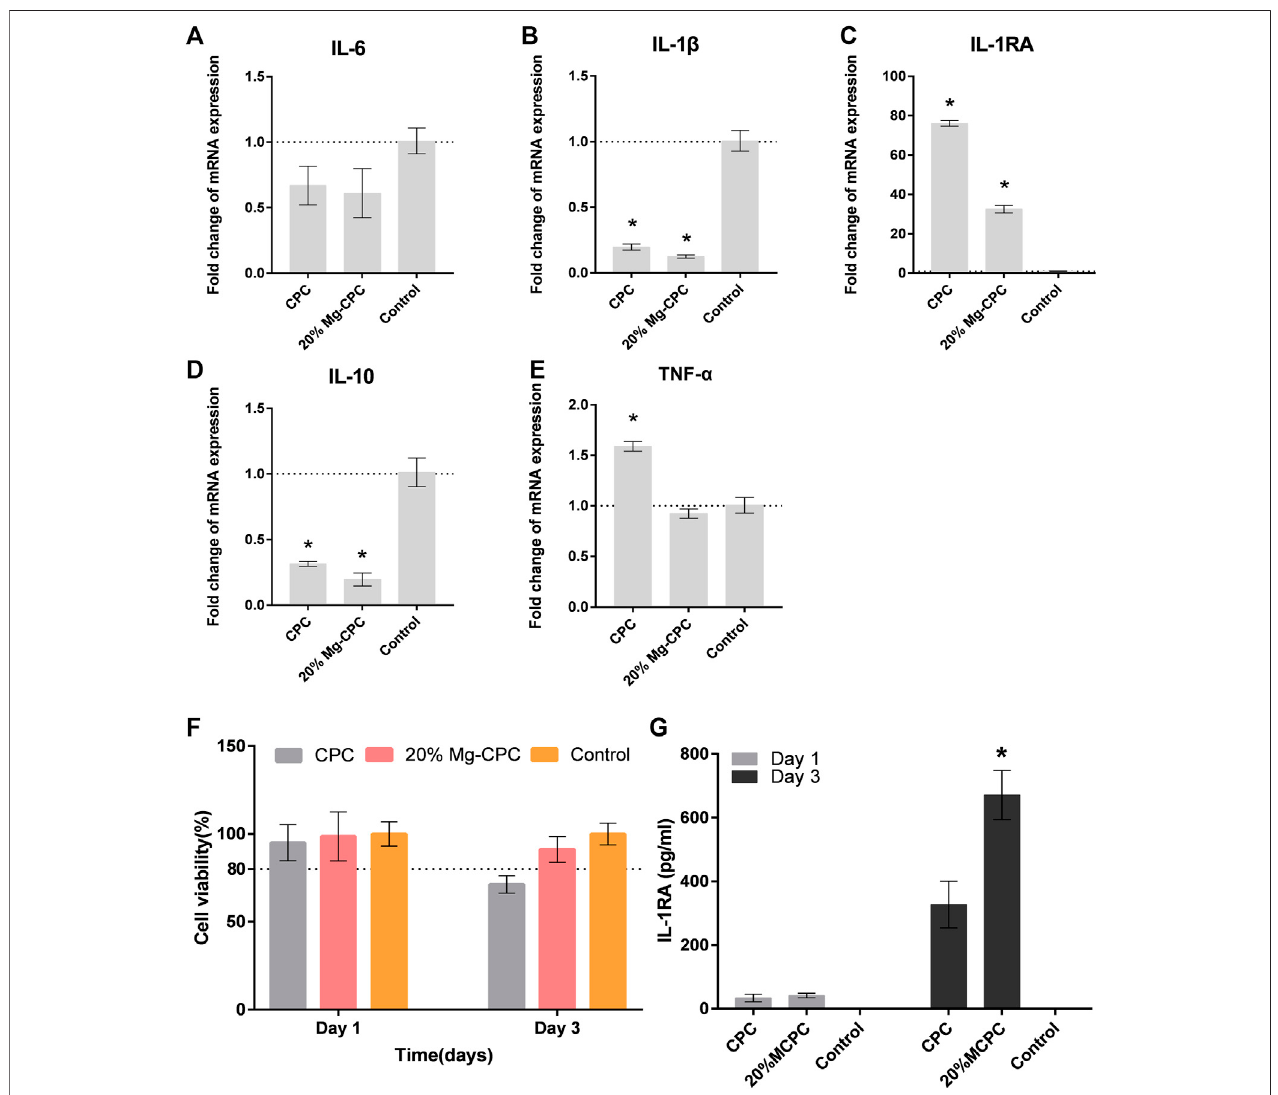
FIGURE 8 | The effect of CPC and Mg-CPC on RAW264.7. (A – E) Gene expression of IL-6, IL-1 β , IL-1Ra, IL-10, and TNF- α after culture on cement, detected by real-time PCR assay. (F) Cell viability assays. (G) The concentration of IL-1RA in the supernatant of RAW264.7 using ELISA (* p < 0.05).